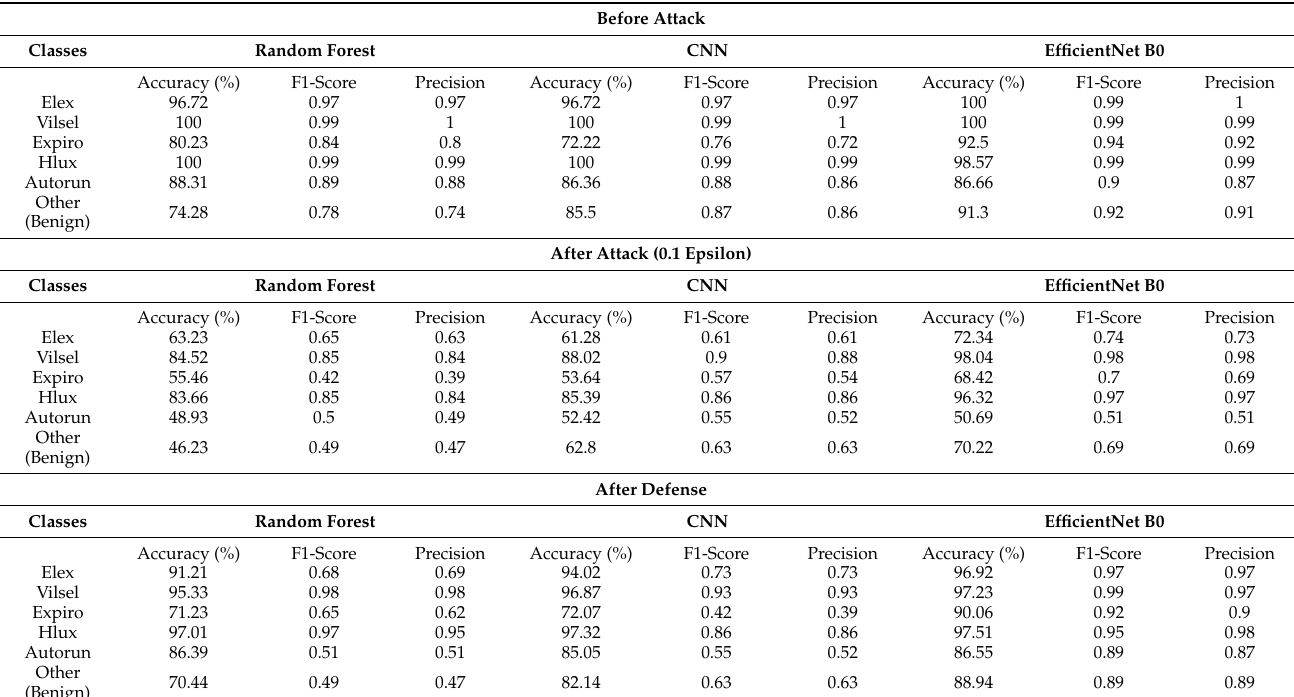
Table 5. Comparative metrics for all models before attack, after attack, and after the defense.